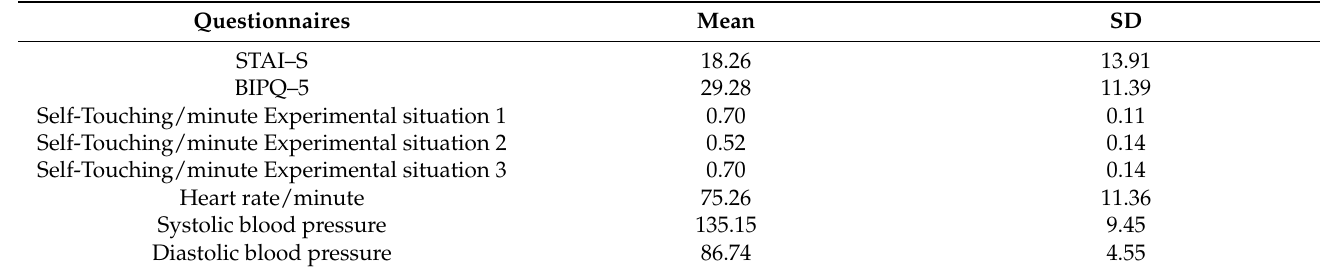
Table 1. Descriptive analysis of the study variables.